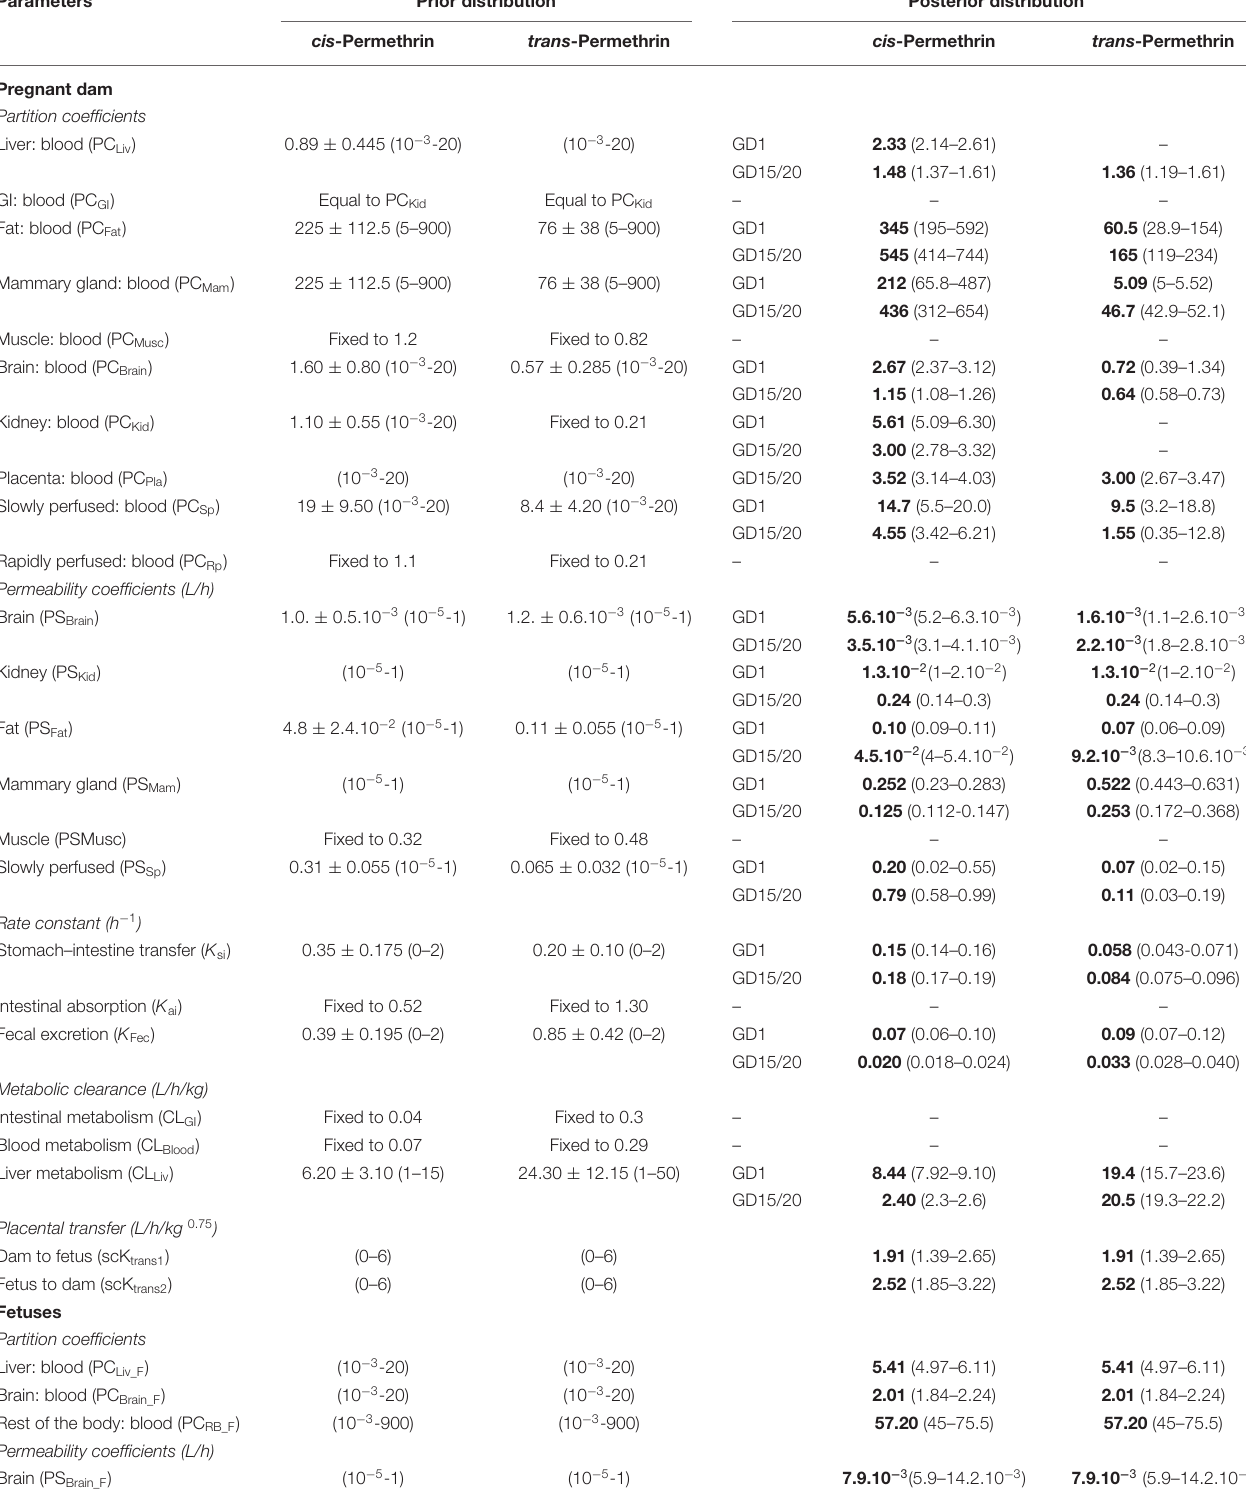
TABLE 2 | Distribution of the chemical specific parameters of the model for permethrin isomers in pregnant rats and fetuses.